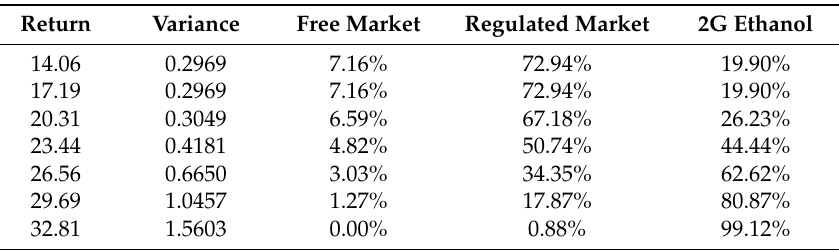
Table 9. Results of the mean-variance model for scenario